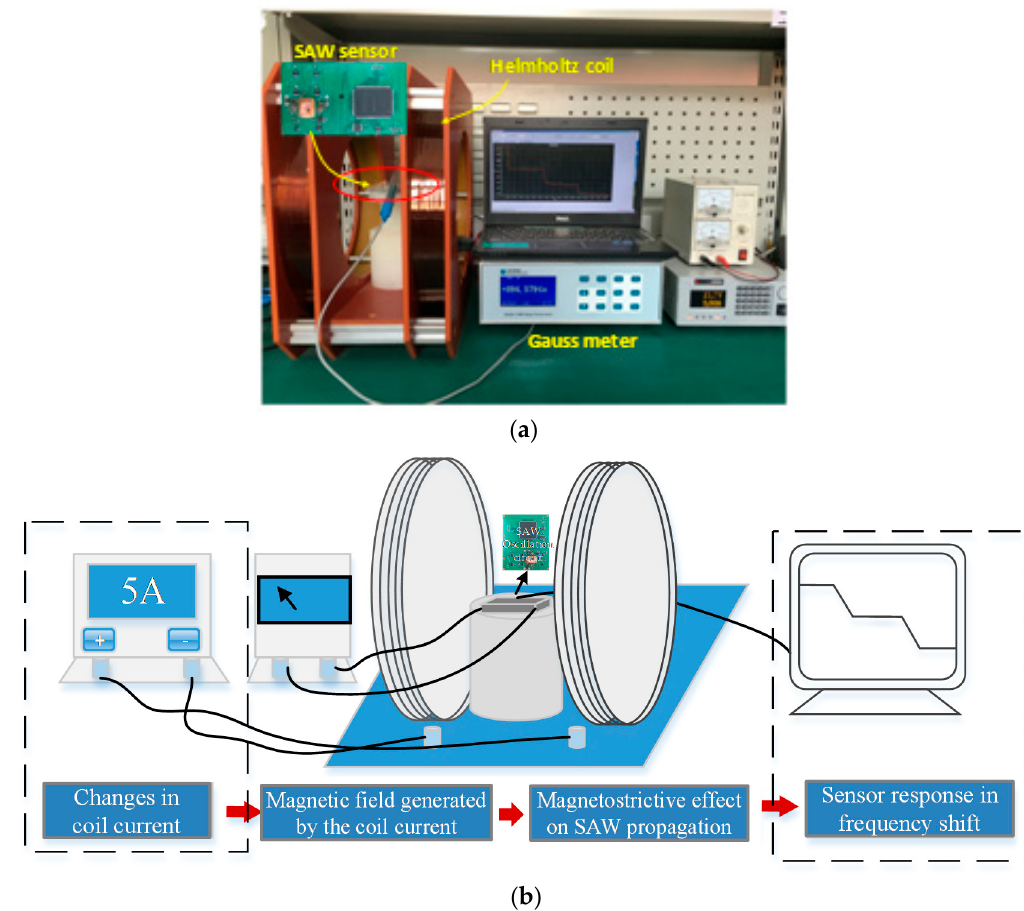
Figure 10. The physical picture and schematic diagraph of the experimental setup for sensor performance evaluation, ( a ) experimental setup; ( b ) working principle.